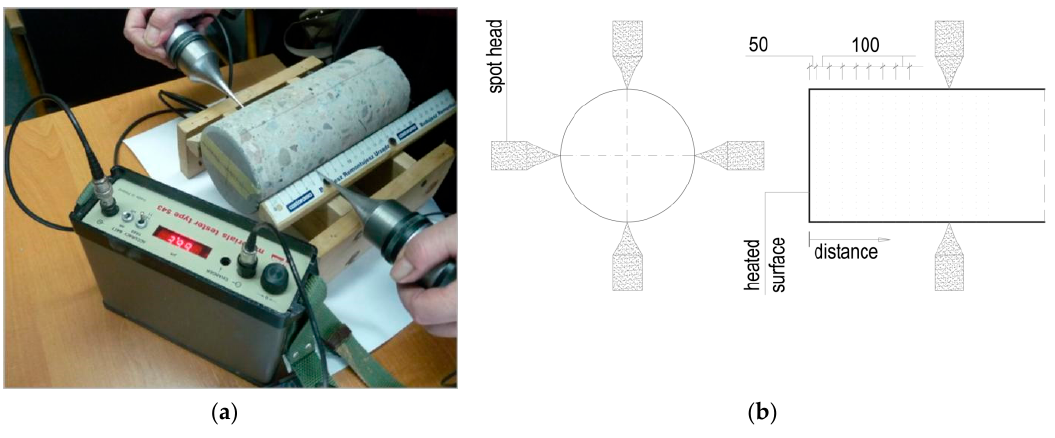
Figure 9. ( a ) Ultrasound Pulse Velocity (UPV) measurements with Unipan 543 and 40 kHz spot heads; ( b ) the head positions during testing.